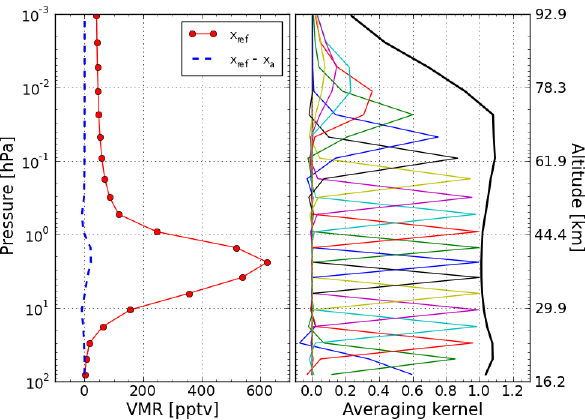
Fig. 3. Reference profile x ref of ClO VMR used in the error analysis. The left figure shows x ref and the difference in x a and x ref . The right figure shows the measurement response (black solid line) and the averaging kernels.